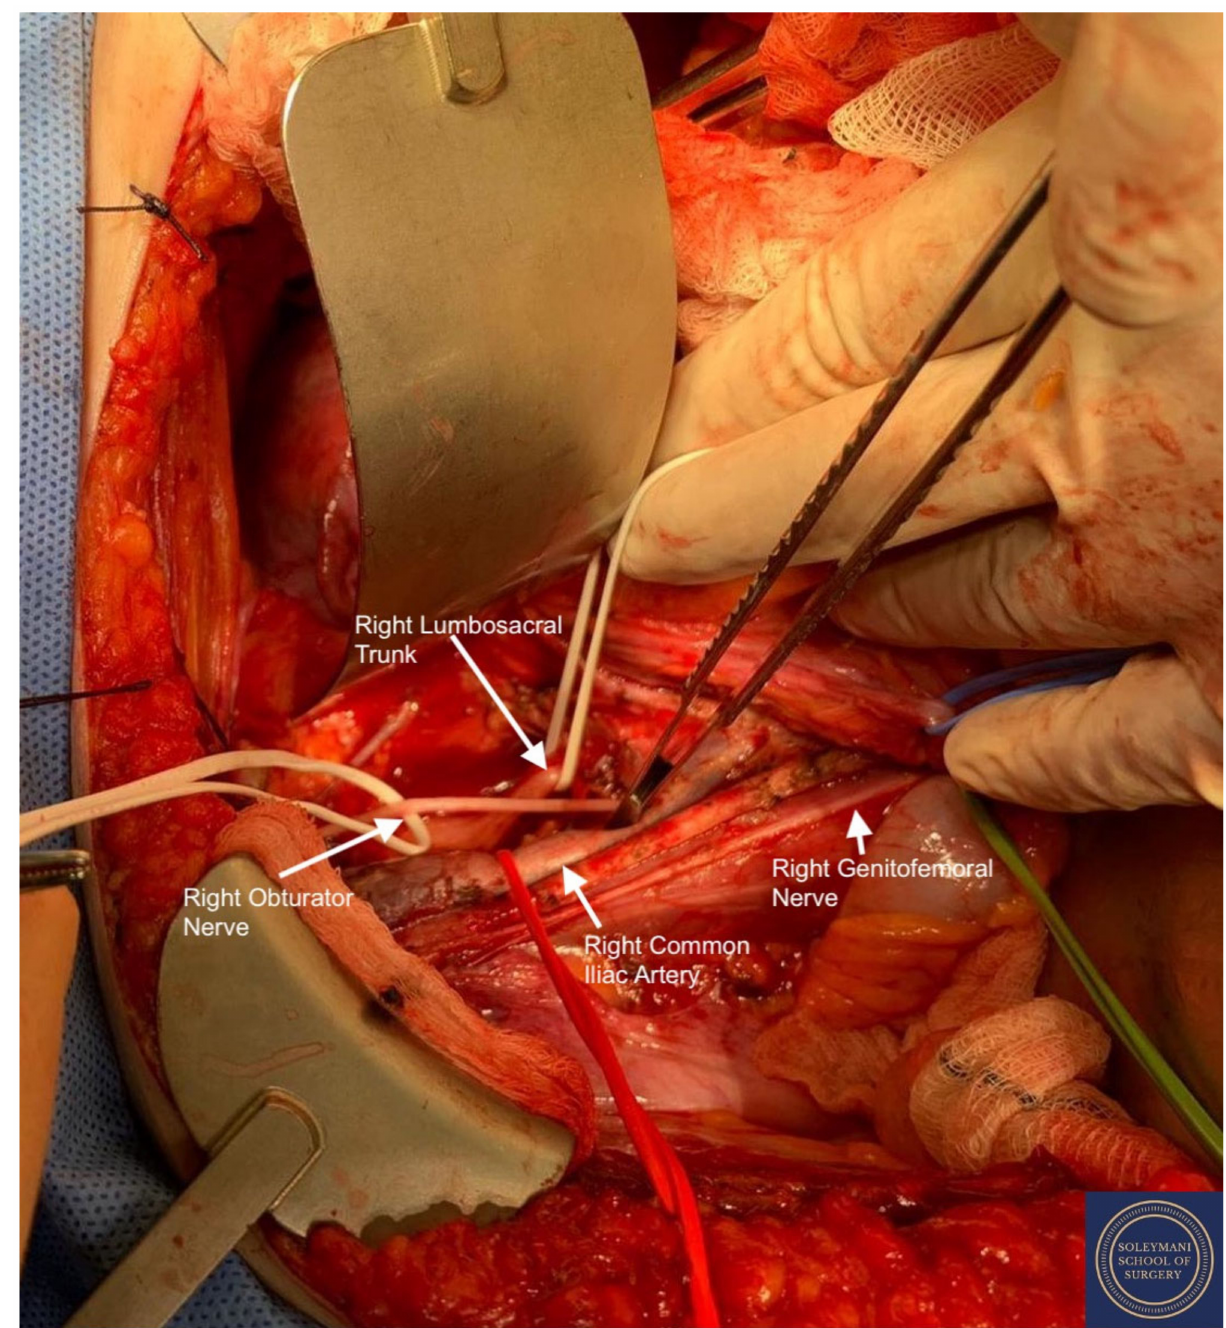
Figure 7. Full exposure of the right lumbosacral fossa with isolation of the following structures: Red Sling = right common iliac artery, Green Sling = right genitofemoral nerve, Upper White Sling = right lumbosacral trunk. L4 L5 S1 S2 roots and sciatic nerve, Lower White Sling = right obturator